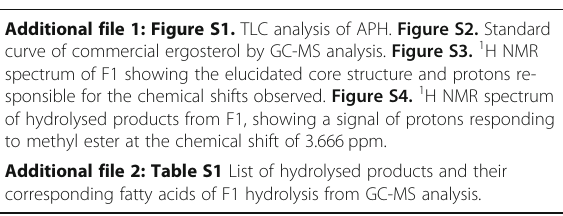
Additional file 1: Figure S1. TLC analysis of APH. Figure S2. Standard curve of commercial ergosterol by GC-MS analysis. Figure S3. 1 H NMR spectrum of F1 showing the elucidated core structure and protons re- sponsible for the chemical shifts observed. Figure S4. 1 H NMR spectrum of hydrolysed products from F1, showing a signal of protons responding to methyl ester at the chemical shift of 3.666 ppm. Additional file 2: Table S1 List of hydrolysed products and their corresponding fatty acids of F1 hydrolysis from GC-MS analysis. Abbreviations AP: Auricularia polytricha ; APH: AP crude hexane extract; HIV-1 PR: HIV-1 protease; HIV-1: Human immunodeficiency virus type